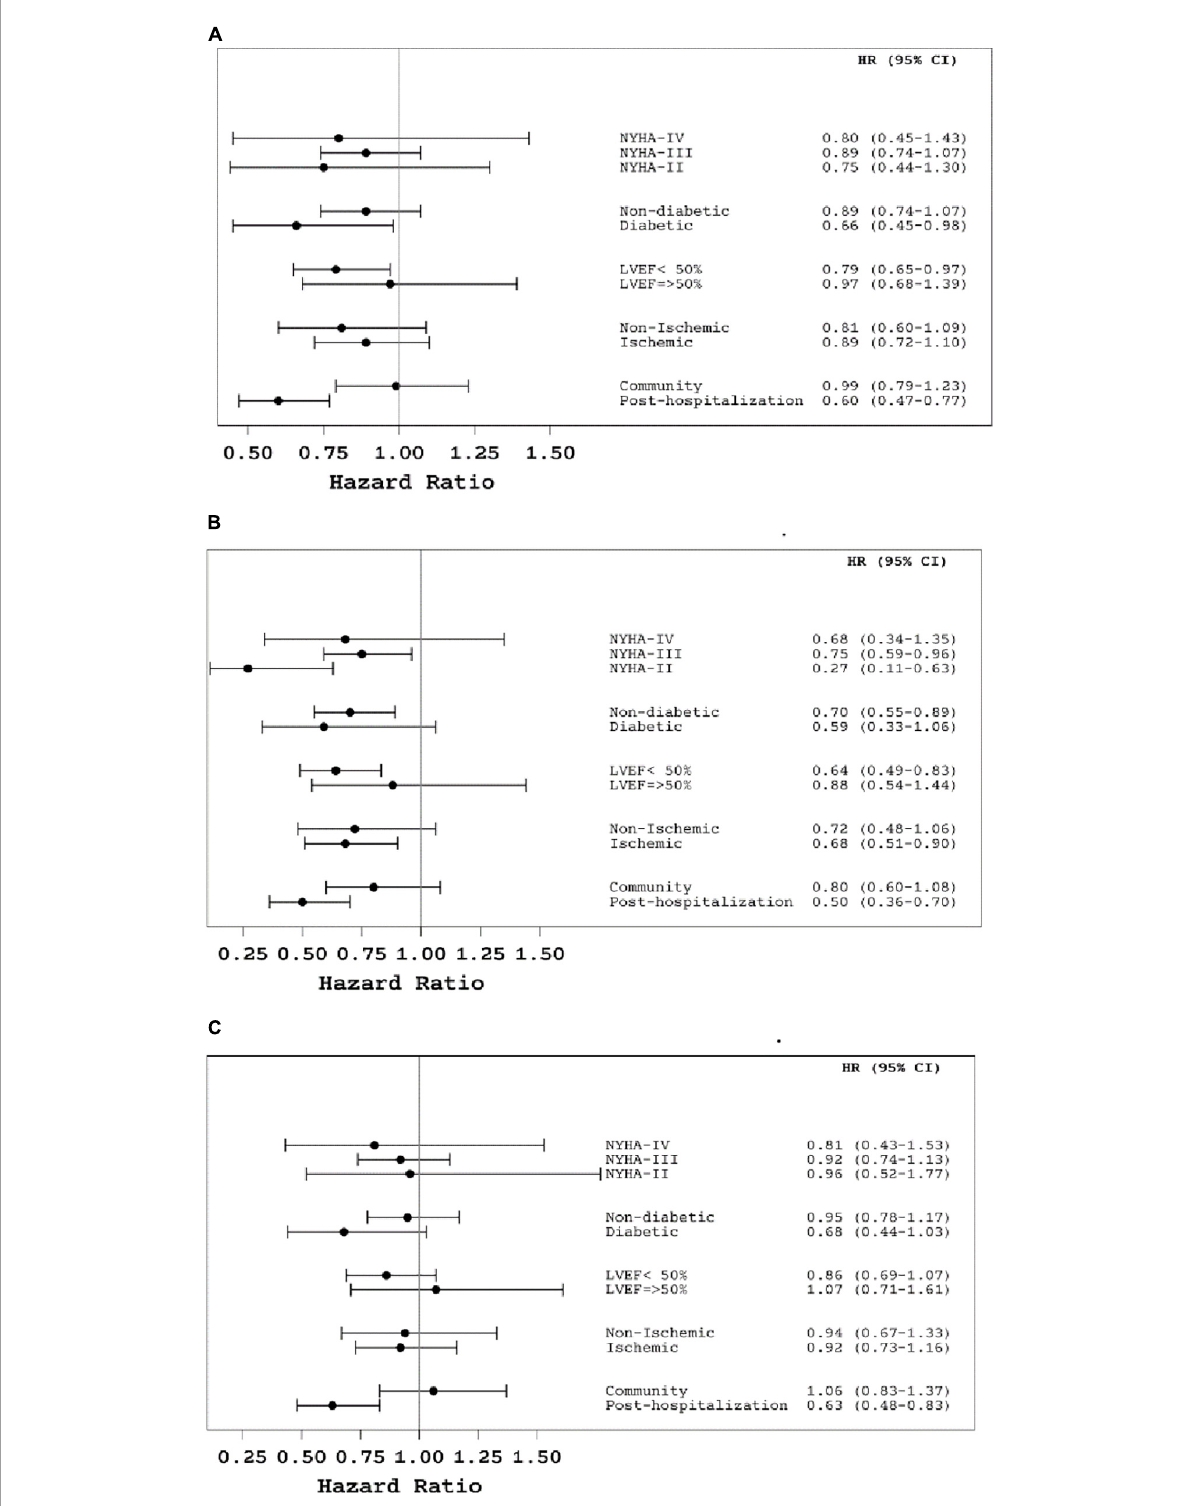
FIGURE3 (A) The effect of sex on the primary composite outcome (time to first heart failure hospitalization or death from all causes) by sub-groups of patients*. (B) The effect of female sex on death from all causes by sub-groups of patients*. (C) The effect of female sex on the time until first heart failure hospitalization by sub-groups of patients*. *The information on the effect of sex in subgroups of patients was derived from Cox proportional hazard models, adjusted for age, study group, heart failure center, and baseline values of NYHA functional class and 6-min walk